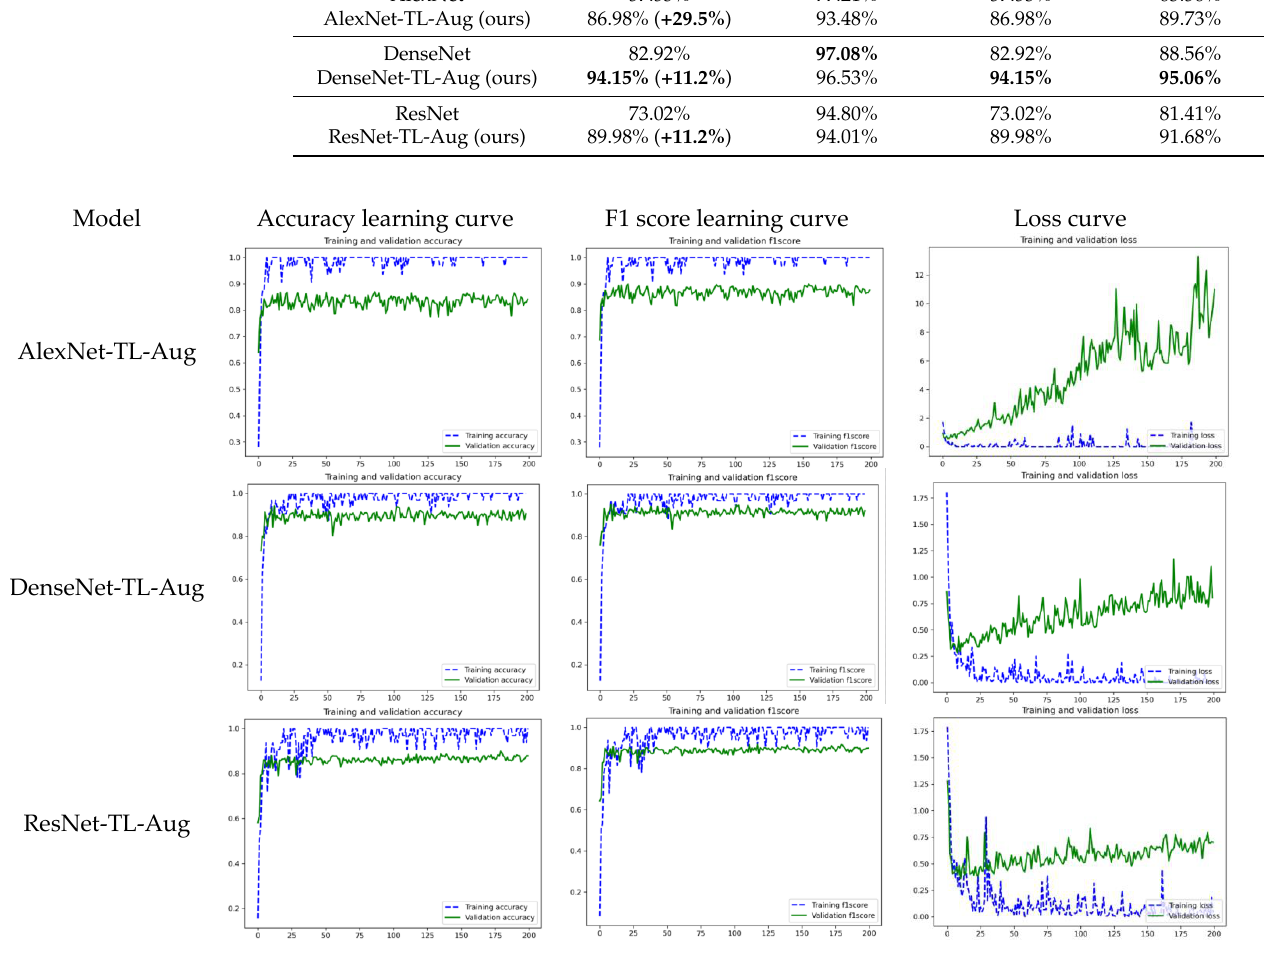
Figure 7. Accuracy, F1 score, and loss learning curve for the proposed CNNs, including AlexNet- TL-Aug, DenseNet-TL-Aug, and